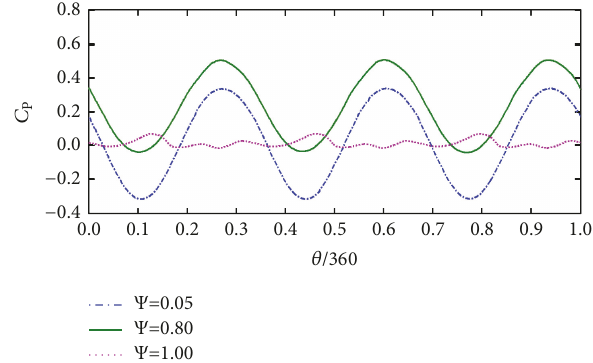
Figure 7: Power coefficient versus azimuth angle for the three considered 𝜓 at Re = 6.82 × 10 5